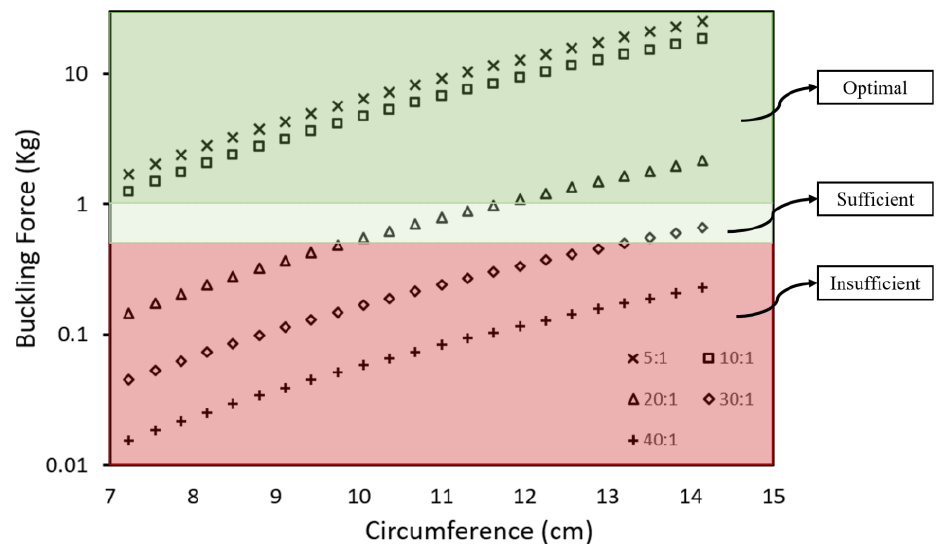
Figure 9. Relationship between the circumference and the resultant buckling force of the different penile models.